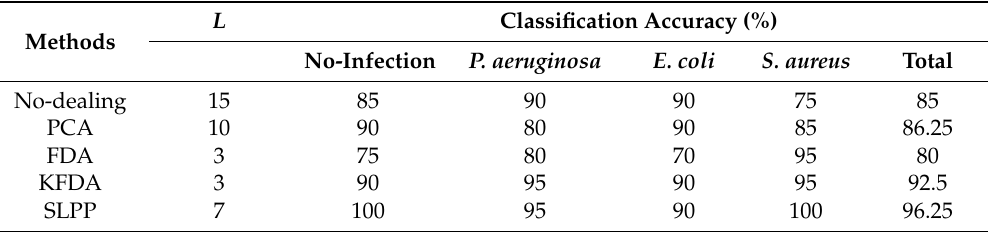
Table 5. Classification results of 40-fold using different data processing methods (SVM).